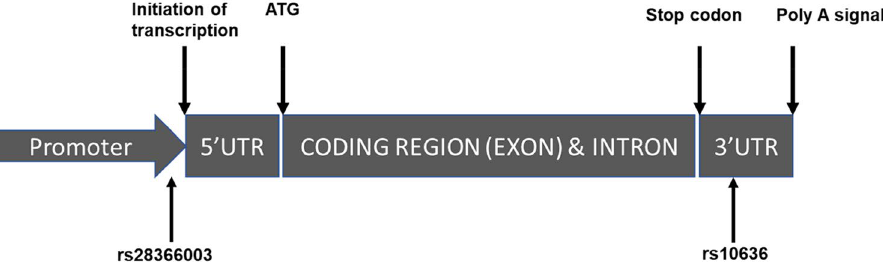
Figure 1. MT2A polymorphisms. Localization of clinically relevant single nucleotide polymorphisms (SNPs) in MT genes. SNP names according to NCBI dbSNP. UTR: untranslated region, ATG: start codon.